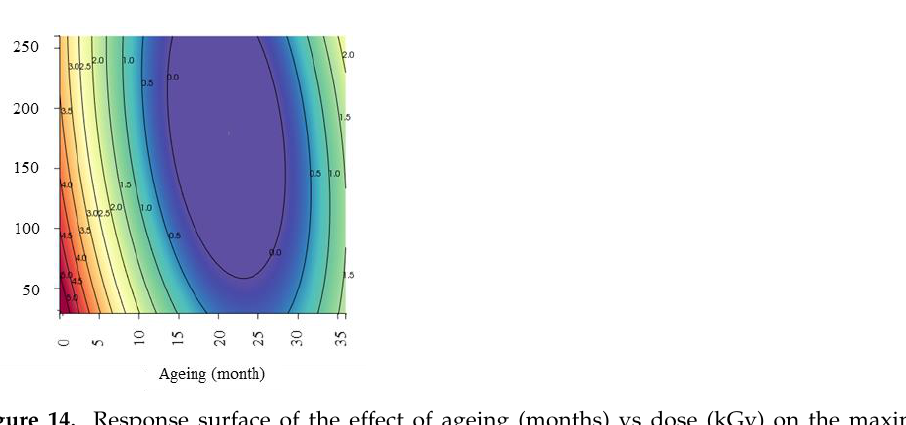
Figure 14. Response surface of the effect of ageing (months) vs dose (kGy) on the maximum methionine sulfoxide (contour in μM) concentration detected. Reproduced from [42] with the permission of Polymers.